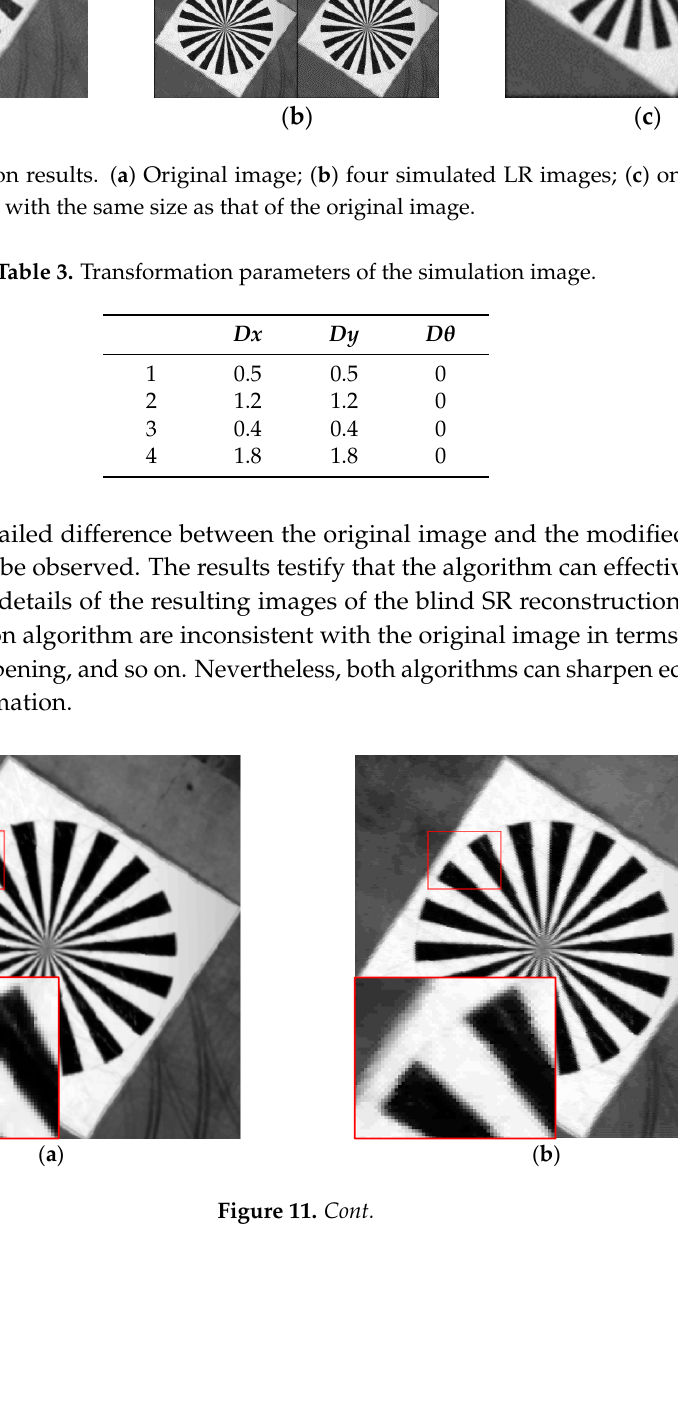
Figure 10. Simulation results. ( a ) Original image; ( b ) four simulated LR images; ( c ) one of the LR interpolated images, with the same size as that of the original image. Table 3. Transformation parameters of the simulation image.